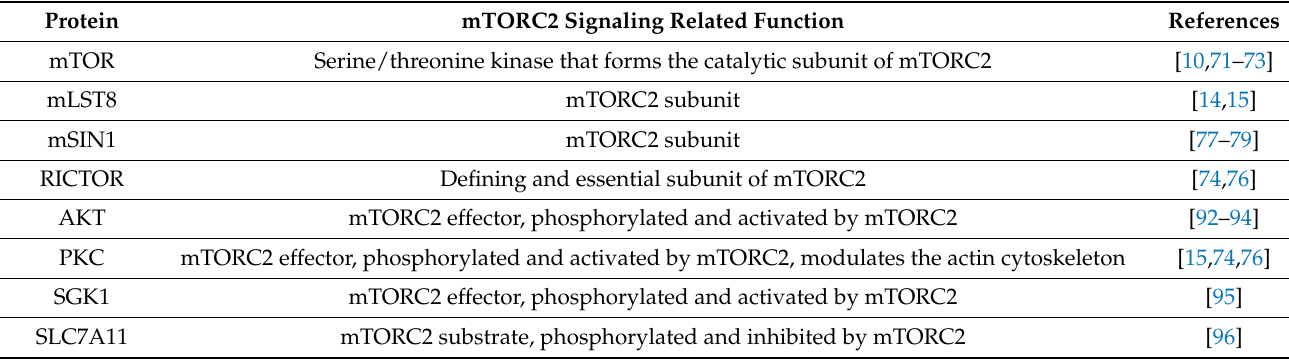
Table 2. Overview of major mTORC2 signaling components discussed in the text and their corresponding functions. Protein mTORC2 Signaling Related